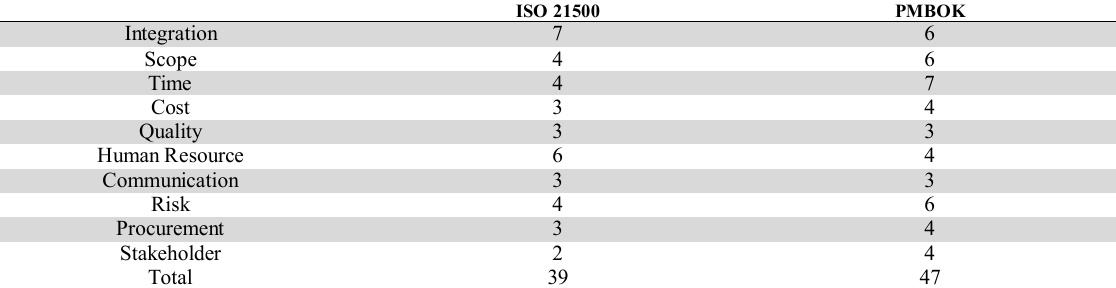
Number of difference